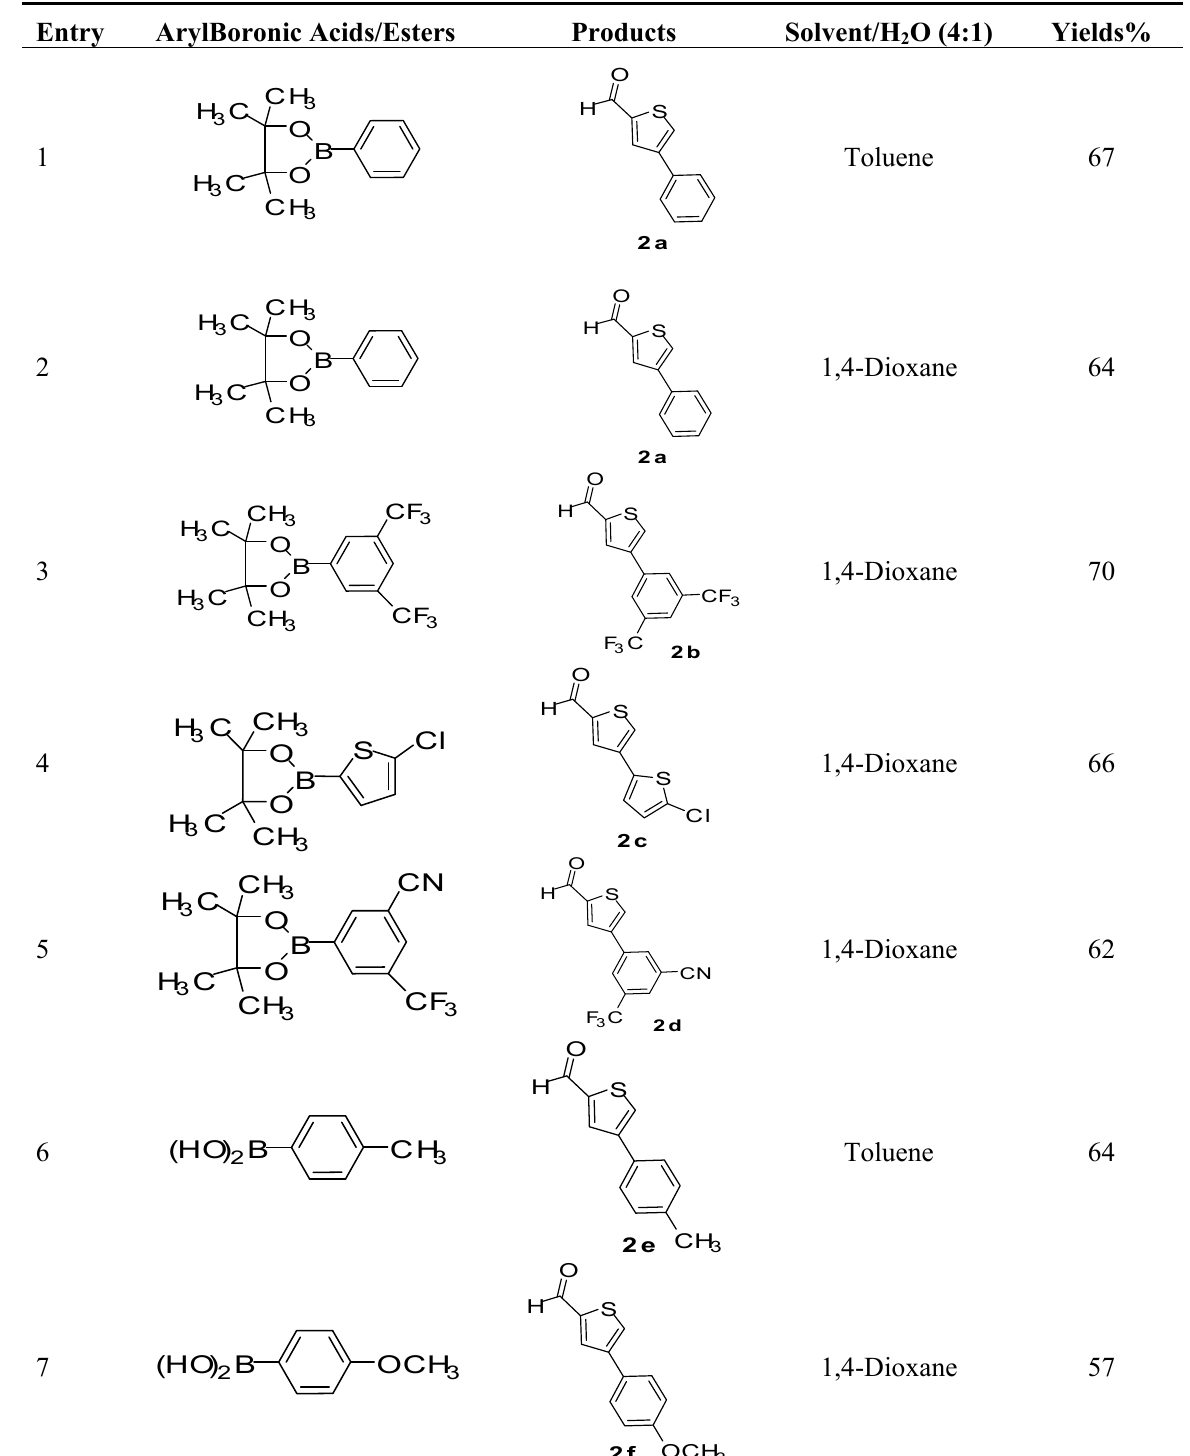
Table 1. Synthesis of